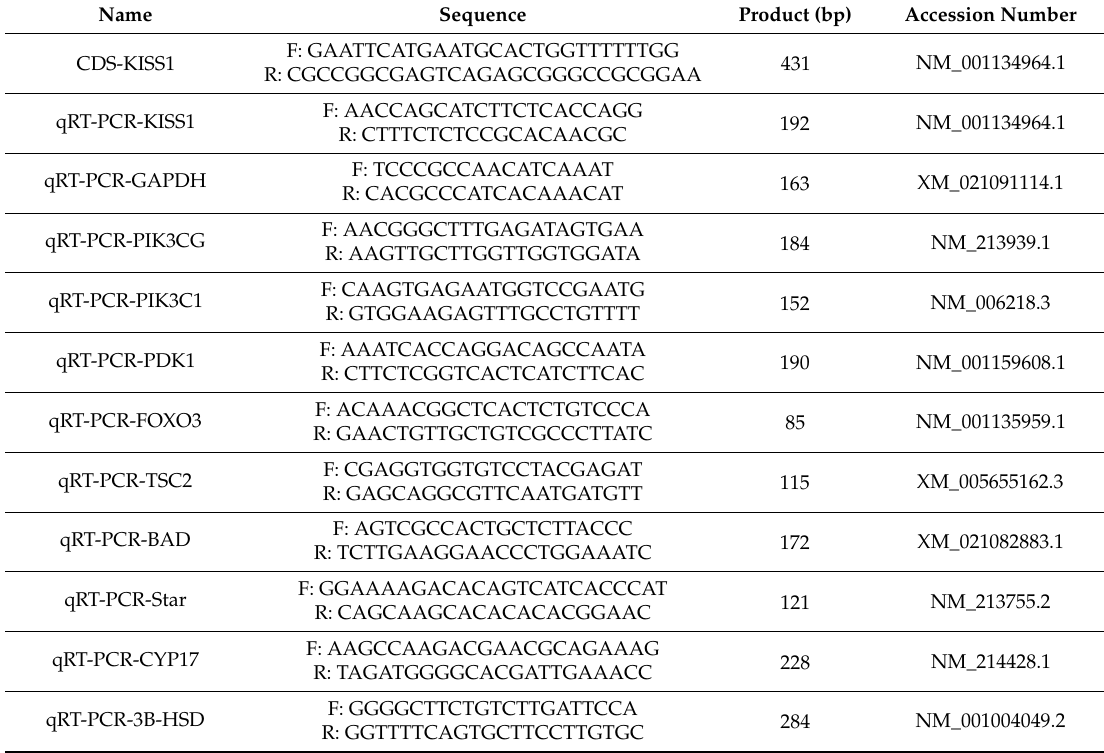
Table 1. Primers used in the present